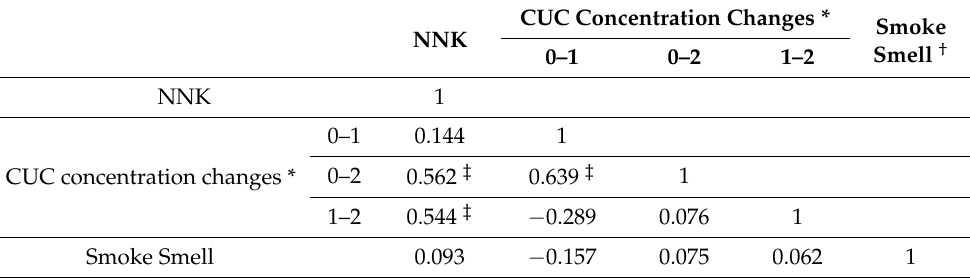
Table 2. Pearson’s correlation of NNK with CUC concentration changes and the smell of